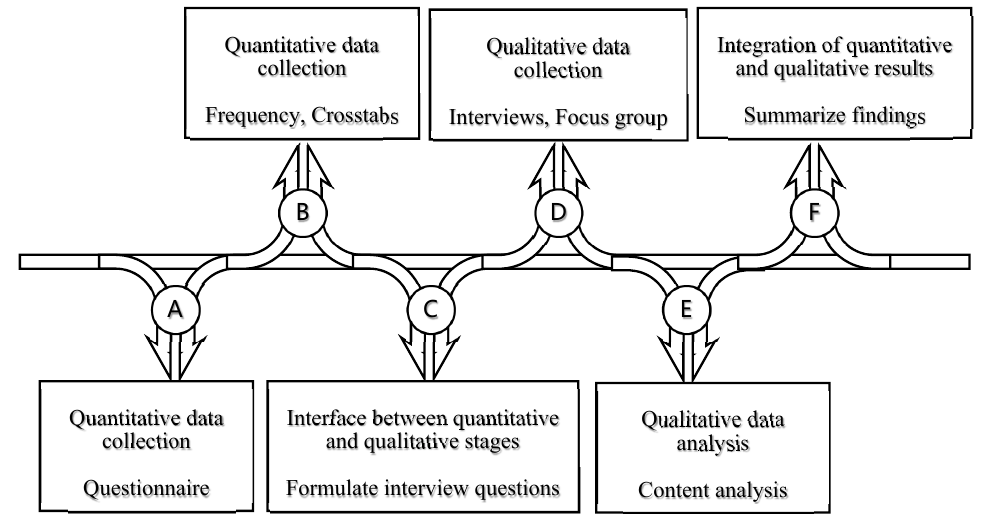
Figure 1. The flowchart of conducting this mixed-method research.